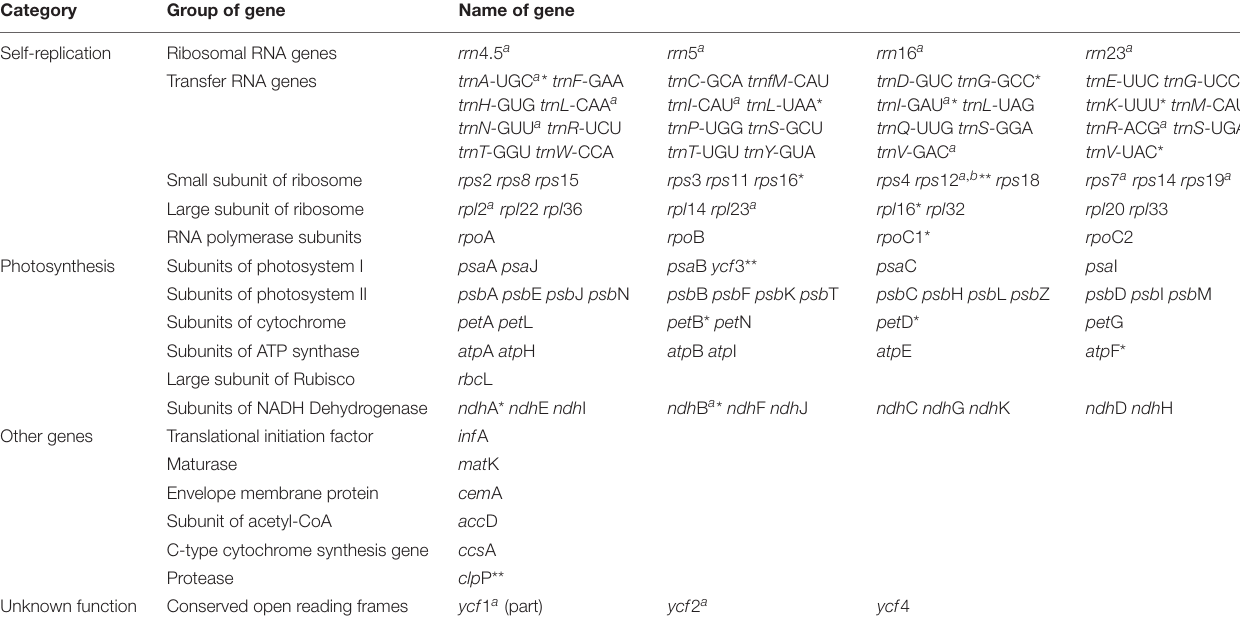
TABLE 3 | Genes contained in Saxifragaceae plastomes (113 genes in